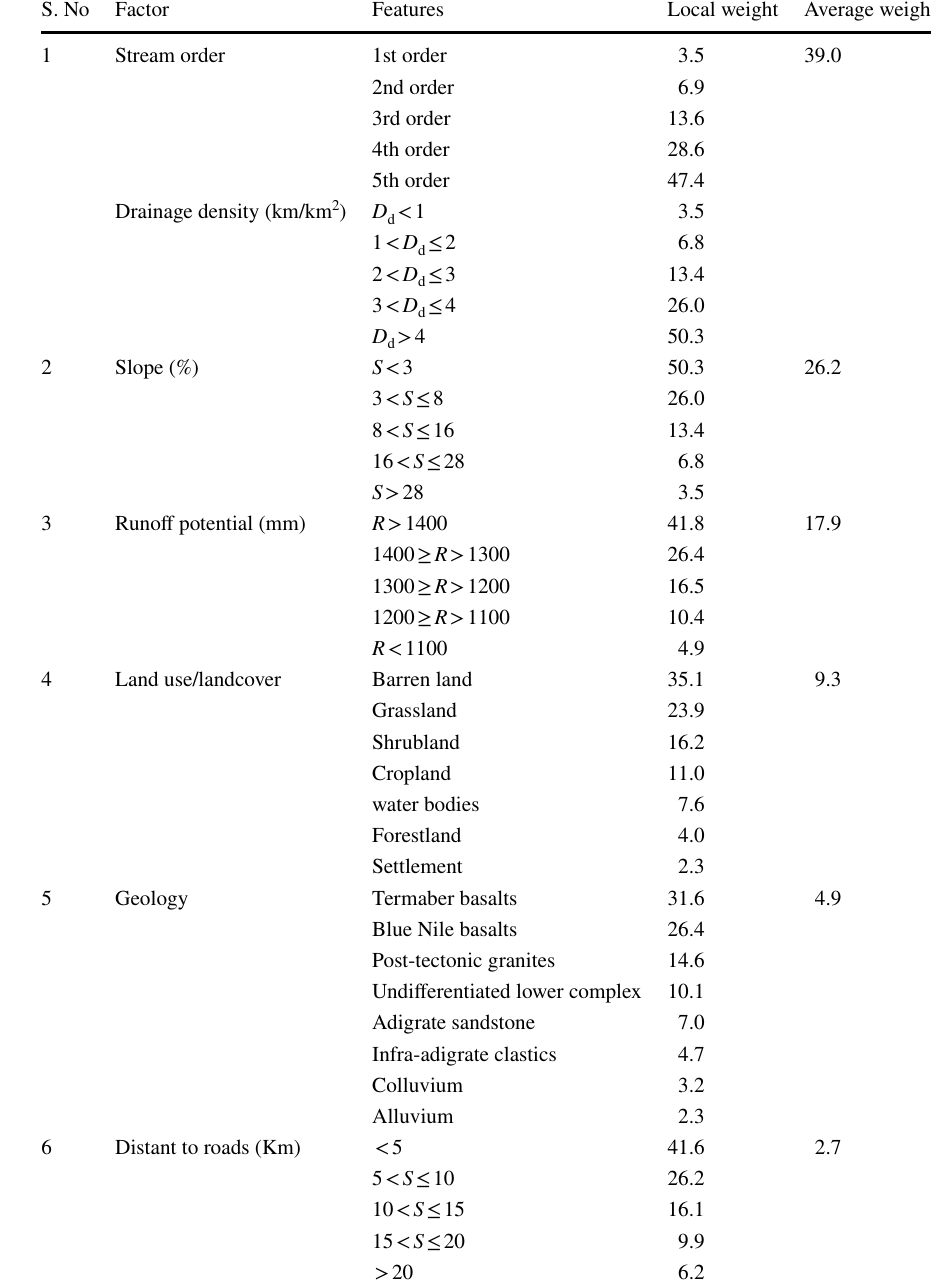
Table 12 Weights of the S. No Factor Features Local thematic layers and runoff map with their assigned weights